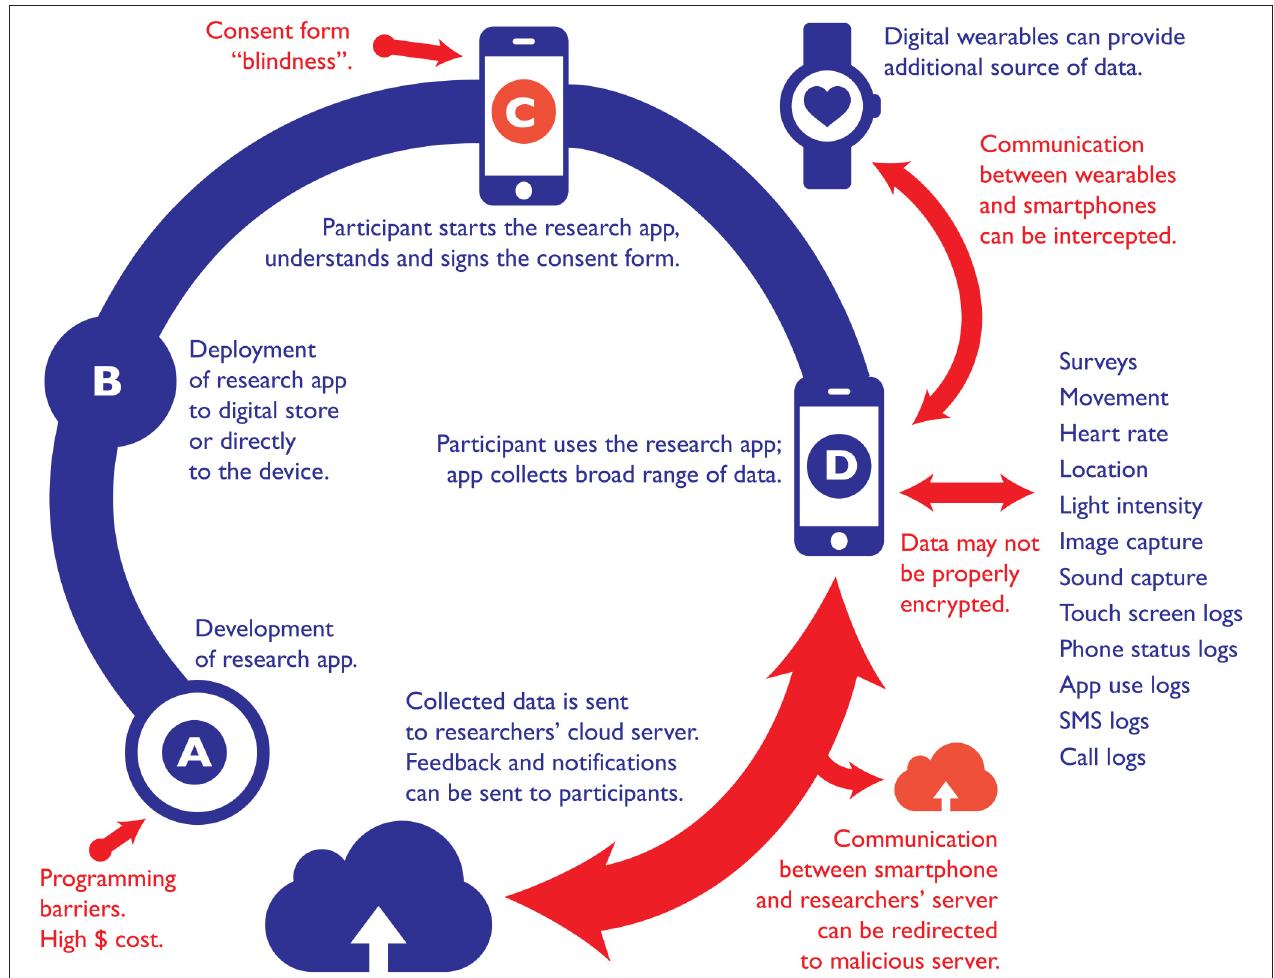
FIGURE 1 | Diagram showing the life cycle of a smartphone research app: (A) development, (B) deployment to a digital store/device, (C) gaining informed consent, and (D) data collection and transfer. Practical barriers and problems are highlighted in